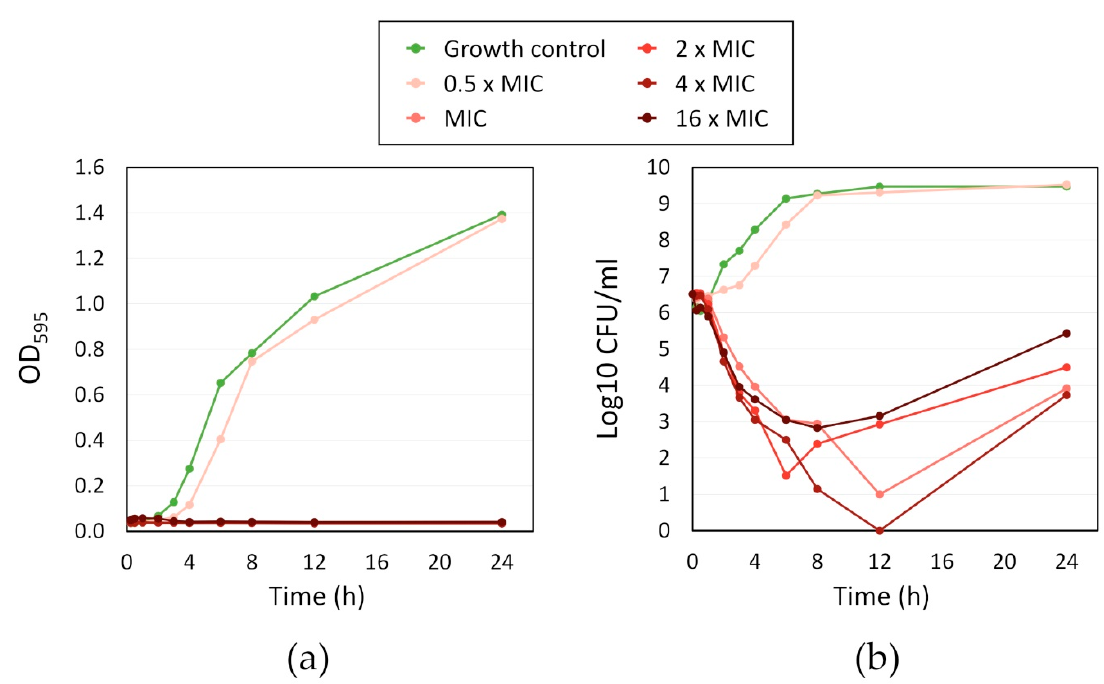
Figure 5. Time-kill kinetic of different folds of the minimum inhibitory concentration (MIC) (12 µM) of fingolimod against S. aureus : ( a ) OD595 of the bacterial culture over time; and ( b ) Log10 of the CFU/mL in the bacterial culture over time. Results are the average of two distinct experiments with each one replicate per concentration.